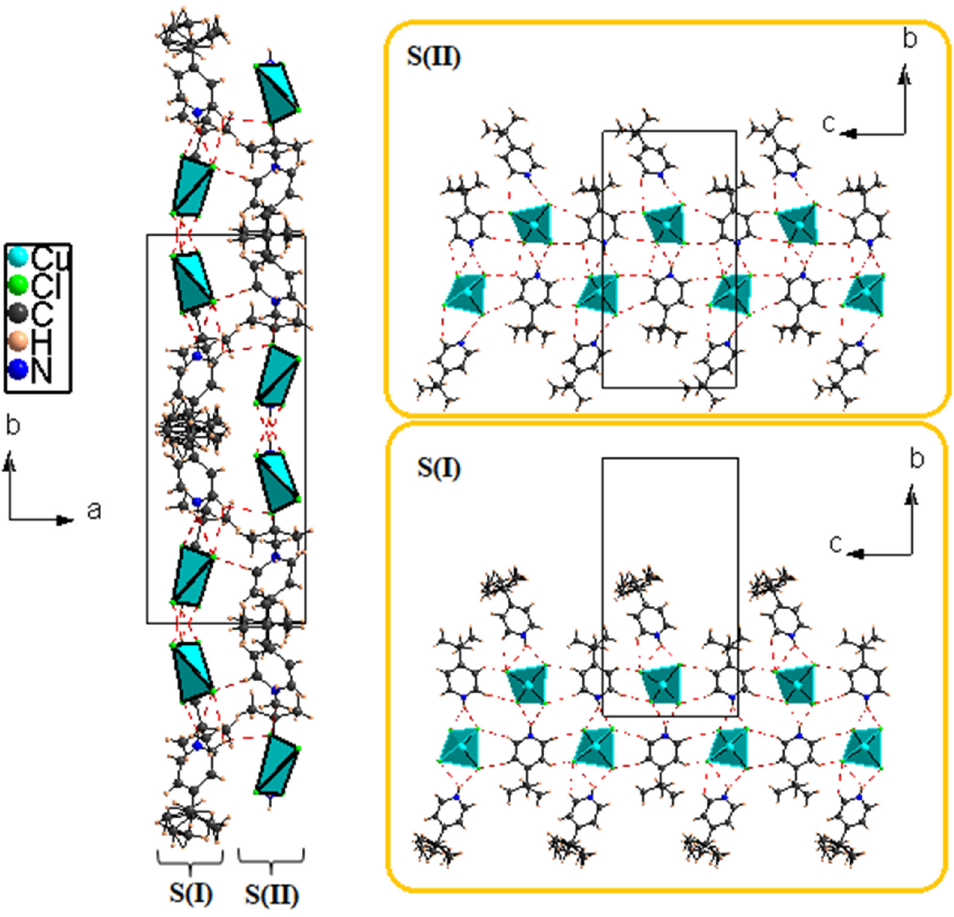
Figure 4. The crystal packing of (C 9 H 14 N) 2 [CuCl 4 ] and therepresentation of the two flat strips S(I) and S(II) along the a -axis.